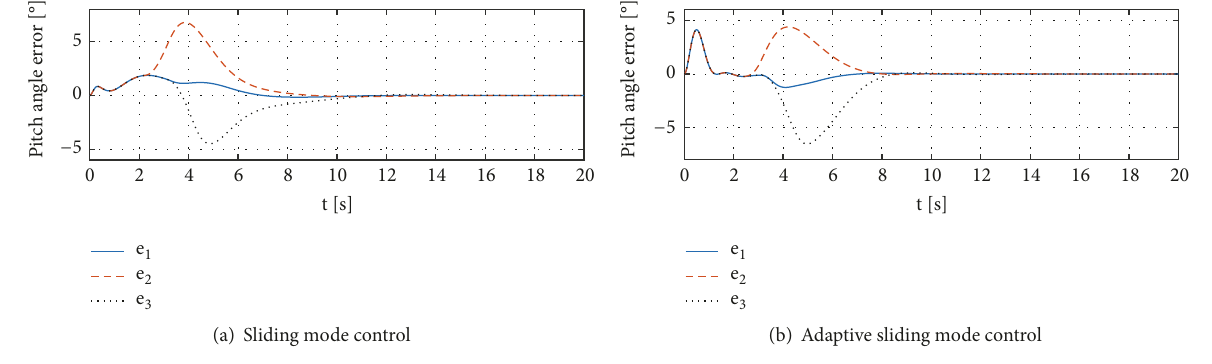
Figure 9: The coordinated errors of pitch